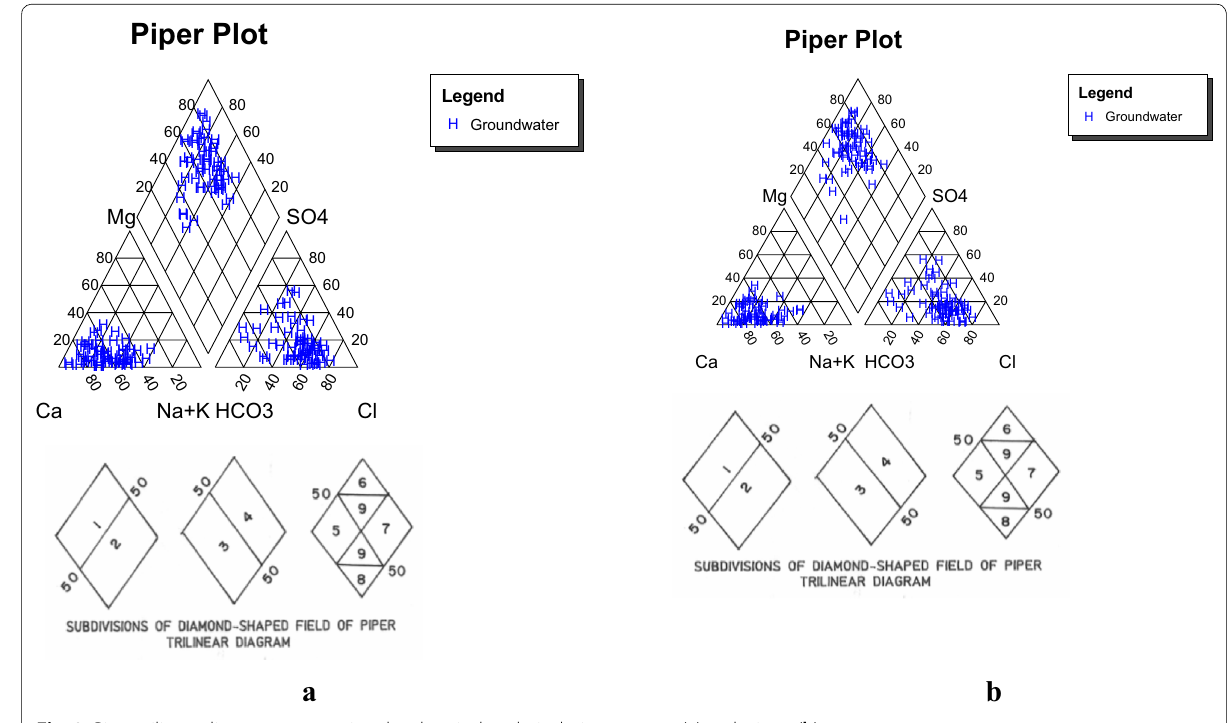
Fig. 2 Piper trilinear diagram representing the chemical analysis during summer ( a ) and winter ( b )